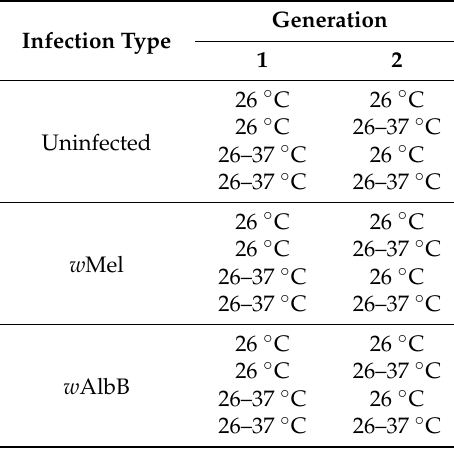
Table 1. Experimental design. Aedes aegypti mosquito larvae for all three infection types (uninfected, w Mel, and w AlbB) were reared at either 26 ◦ C or 26–37 ◦ C in the first generation. Offspring of parents from each treatment were then reared at either 26 ◦ C or 26–37 ◦